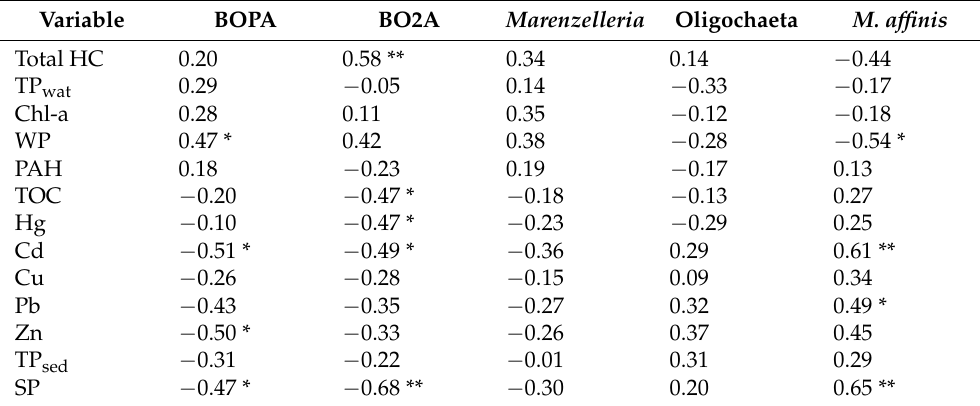
Table 2. Spearman Rank Order Correlations between BOPA and BO2A indices, benthic species abundance, and pollution-related variables. * p ≤ 0.05, ** p ≤ 0.01.